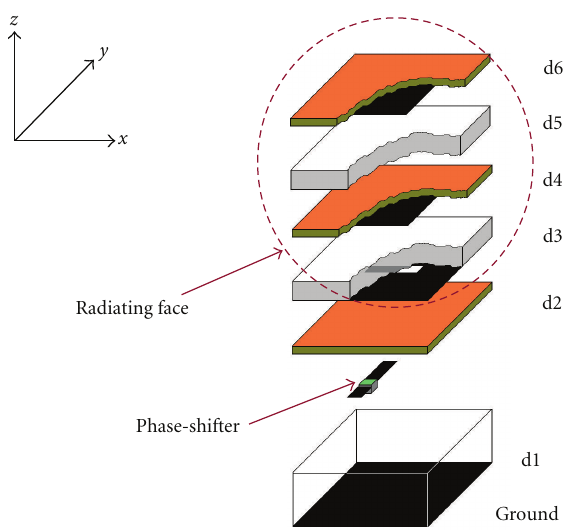
Figure 11: Expanded view of a single reconfigurable element based on patches, aperture-coupled to delay lines with two stacked